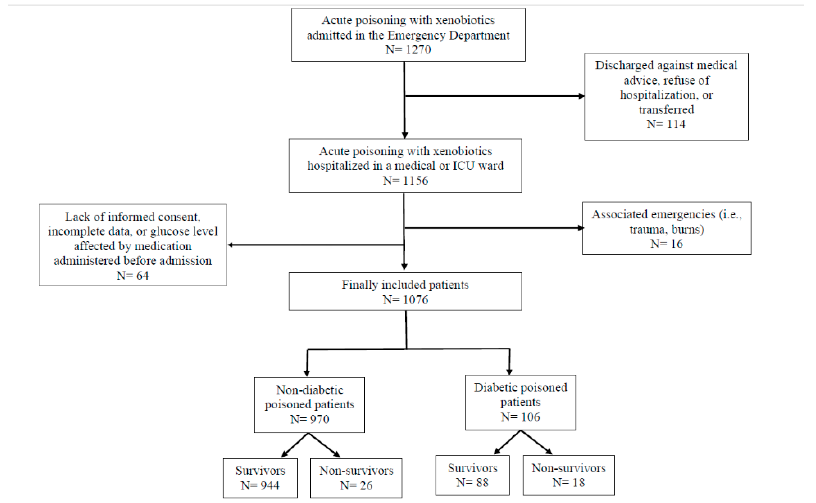
Figure 1. Study flow diagram.